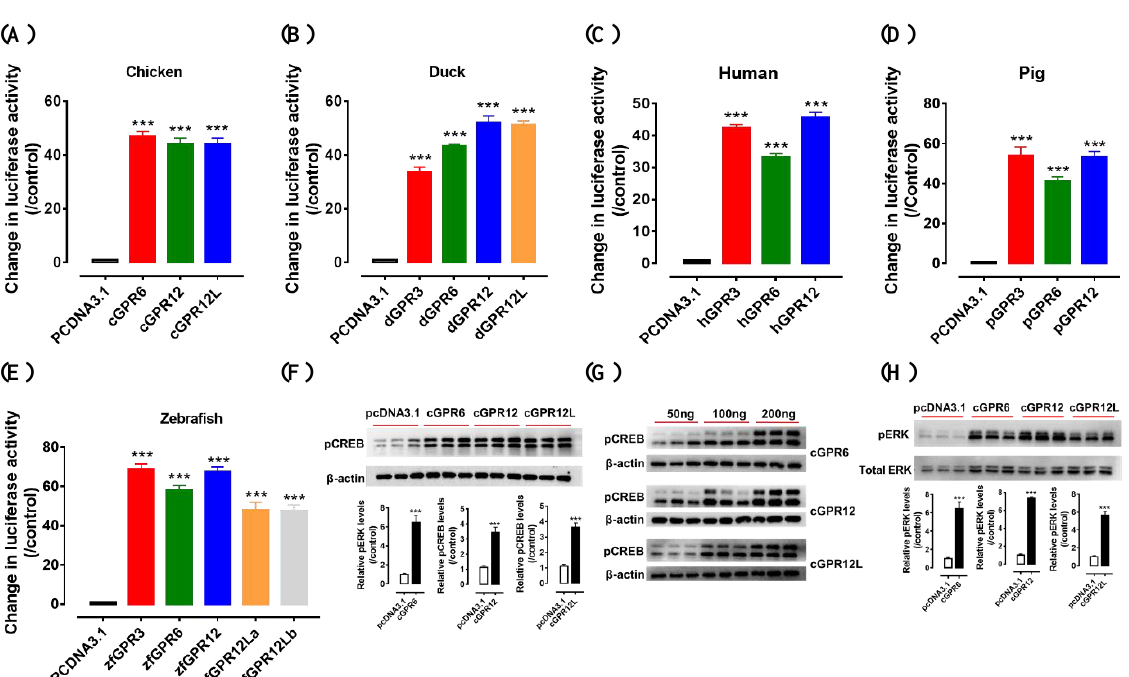
Figure 4. Constitutive activity of GPR3, GPR6, GPR12, and GPR12L(s) in chicken ( A ), duck ( B ), human ( C ), pig ( D ), and zebrafish ( E ). The activity of each receptor expressed in human embryonic kidney 293 (HEK293) cells was detected by dual-luciferase reporter assay. Each data point represents the mean ± SEM of 4 replicates ( N = 4). ***, p < 0.001 vs. control (cells transfected with empty pcDNA3.1(+) vector). Western blot detection of the phosphorylated CREB (pCREB, ( F )) and ERK (pERK, ( H )) in HEK293 cells expressing cGPR6, cGPR12, and cGPR12L. pCREB and pERK levels were first normalized by that of actin and total ERK (tERK), respectively, and then expressed as the fold increase compared with the control group (transfected with empty pcDNA3.1(+) vector). ***, p < 0.001 vs. control. ( G ) The levels of pCREB increase dose-dependently in HEK293 cells transfected with increasing amount of cGPR6, cGPR12, or cGPR12L expression plasmid (50 ng, 100 ng, and 200 ng). Note. zebrafish has two GPR12L genes ( GPR12La and GPR12Lb ).